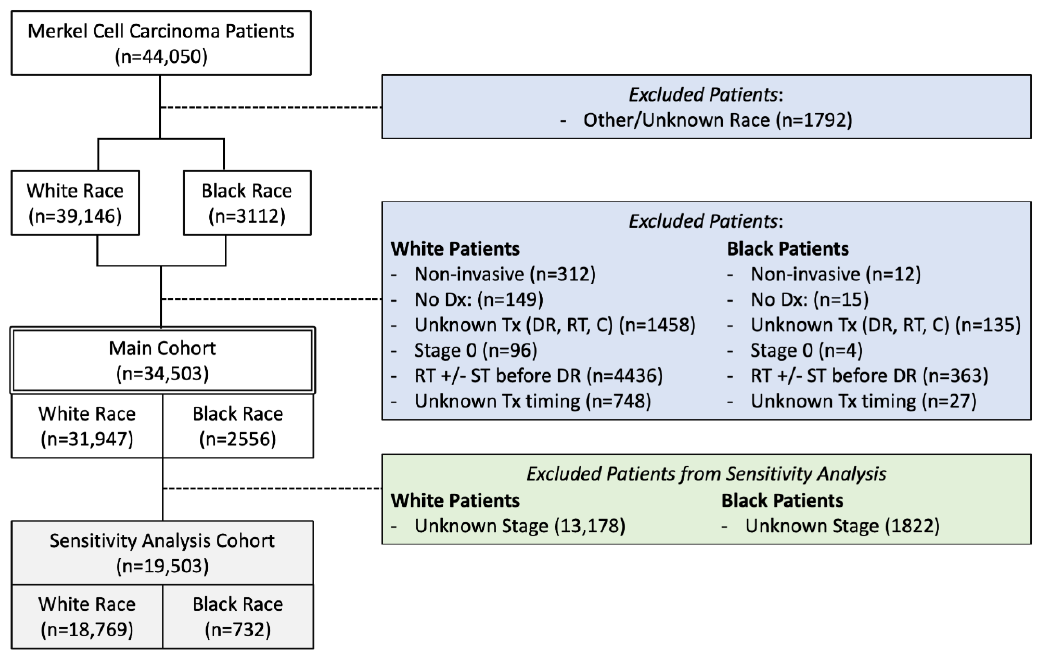
Figure 1. Flow Chart of Study Inclusion Criteria. C = Chemotherapy, DR = Definitive resection, Dx = Diagnostic confirmation, RT = Radiation therapy, ST = Systemic therapy, Tx = Treatment, +/ − = with or